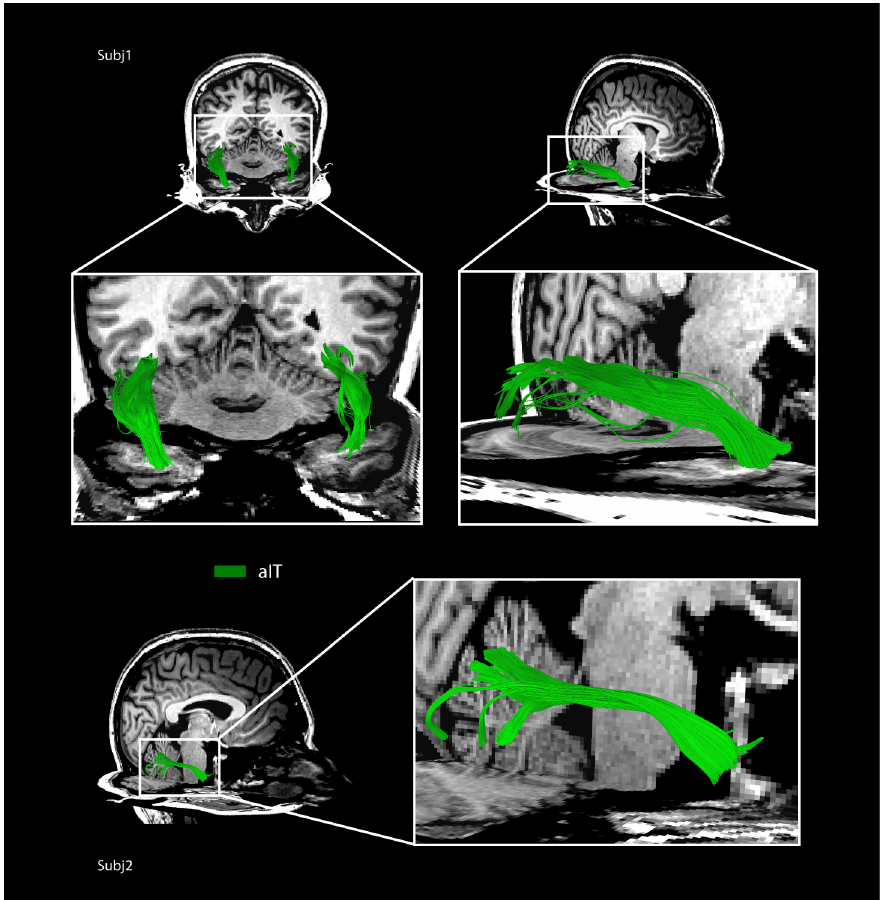
Figure 5. Fiber tracks connecting right mFus to aIT in two representative participants. In Subj1, two views are shown: partial bilateral tracks from above shown intersecting a coronal co-registered T1 anatomical slice (upper left), and the complete right track shown from the side (upper right). Note good correspondence between white matter in the T1 anatomical and the location of fiber tracks passing through the coronal slice. In Subj2 a complete right hemisphere track is shown from the side.